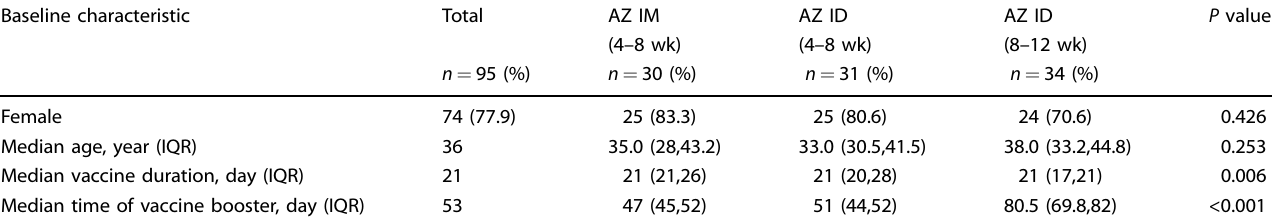
Table 1. Baseline characteristics of the intramuscular and intradermal. boosted ChAdOx1 nCoV-19 (Oxford-AstraZeneca; AZ) in the tested groups. Baseline characteristic